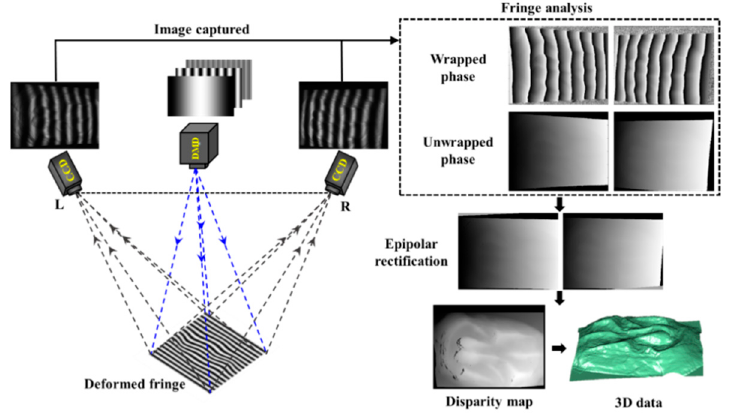
Figure 3. Schematic diagram of 3D reconstruction of binocular system based on phase matching.